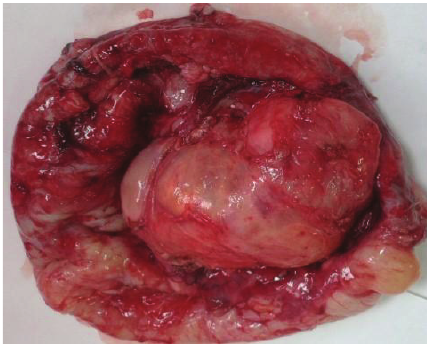
Figure5:Thetumorexcisedenbloc,pink-colored,andwellcircum- scribed.